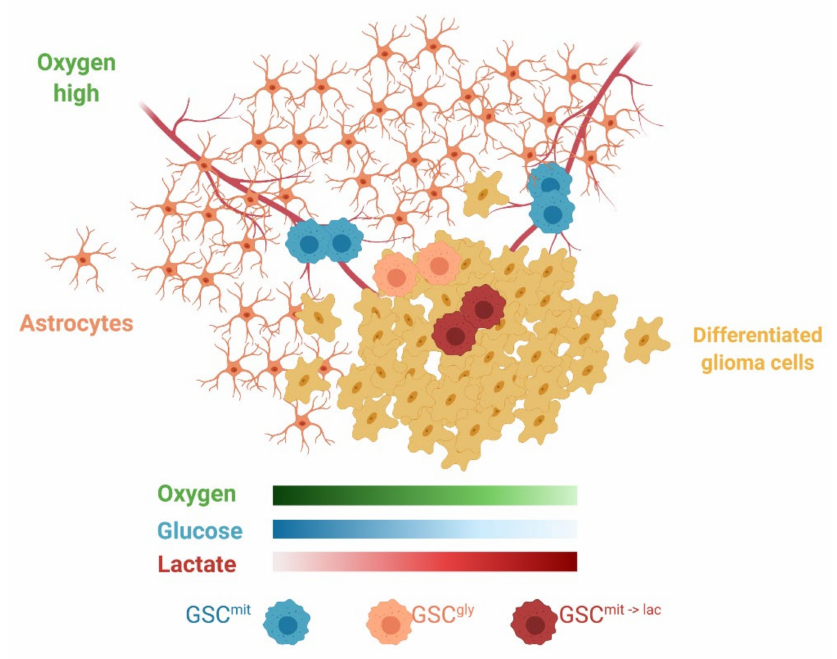
Figure 7. Schematic representation of the heterogeneous microenvironment present in GBM. Astro- cytes, GSC gly , and differentiated glioma cells all consume glucose, rely on glycolysis, and release lactate, thus potentially creating areas favorable for GSC mit to switch to lactate as an alternative carbon source (GSC mit->lac ) and leading to metabolic cooperation or symbiosis. Created with